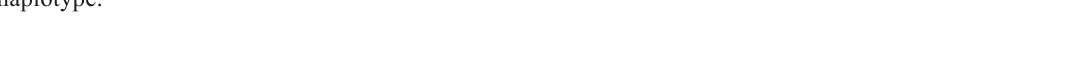
Fig. 4. Minimum spanning network of P . albicans haplotypes . The number of mutational steps separating each haplotype were represented by dots. Pointed branches represent alternatives links. The size of the circles represents the frequency of each